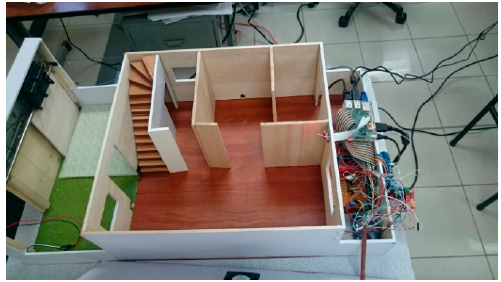
Figure 7. Photograph of the model built to emulate unwanted intrusions in a Smart Home.